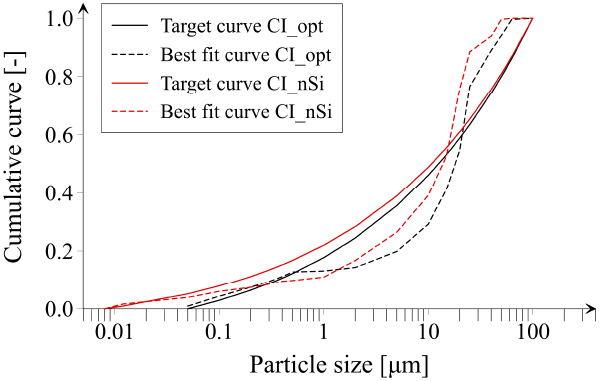
Figure 6. Particles size distribution of optimized cement paste mixes. Table 3. Composition of the designed cement paste mixes used in tests.